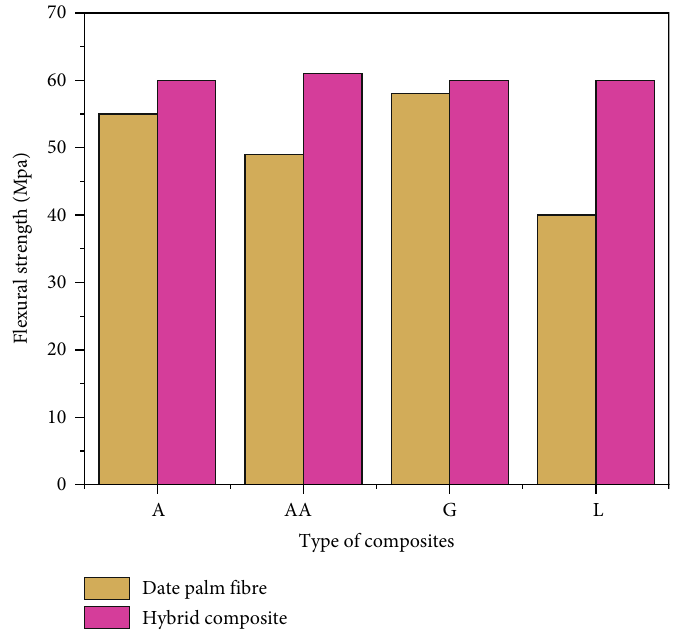
Figure 9: Flexural strength of DPF and hybrid composite fi